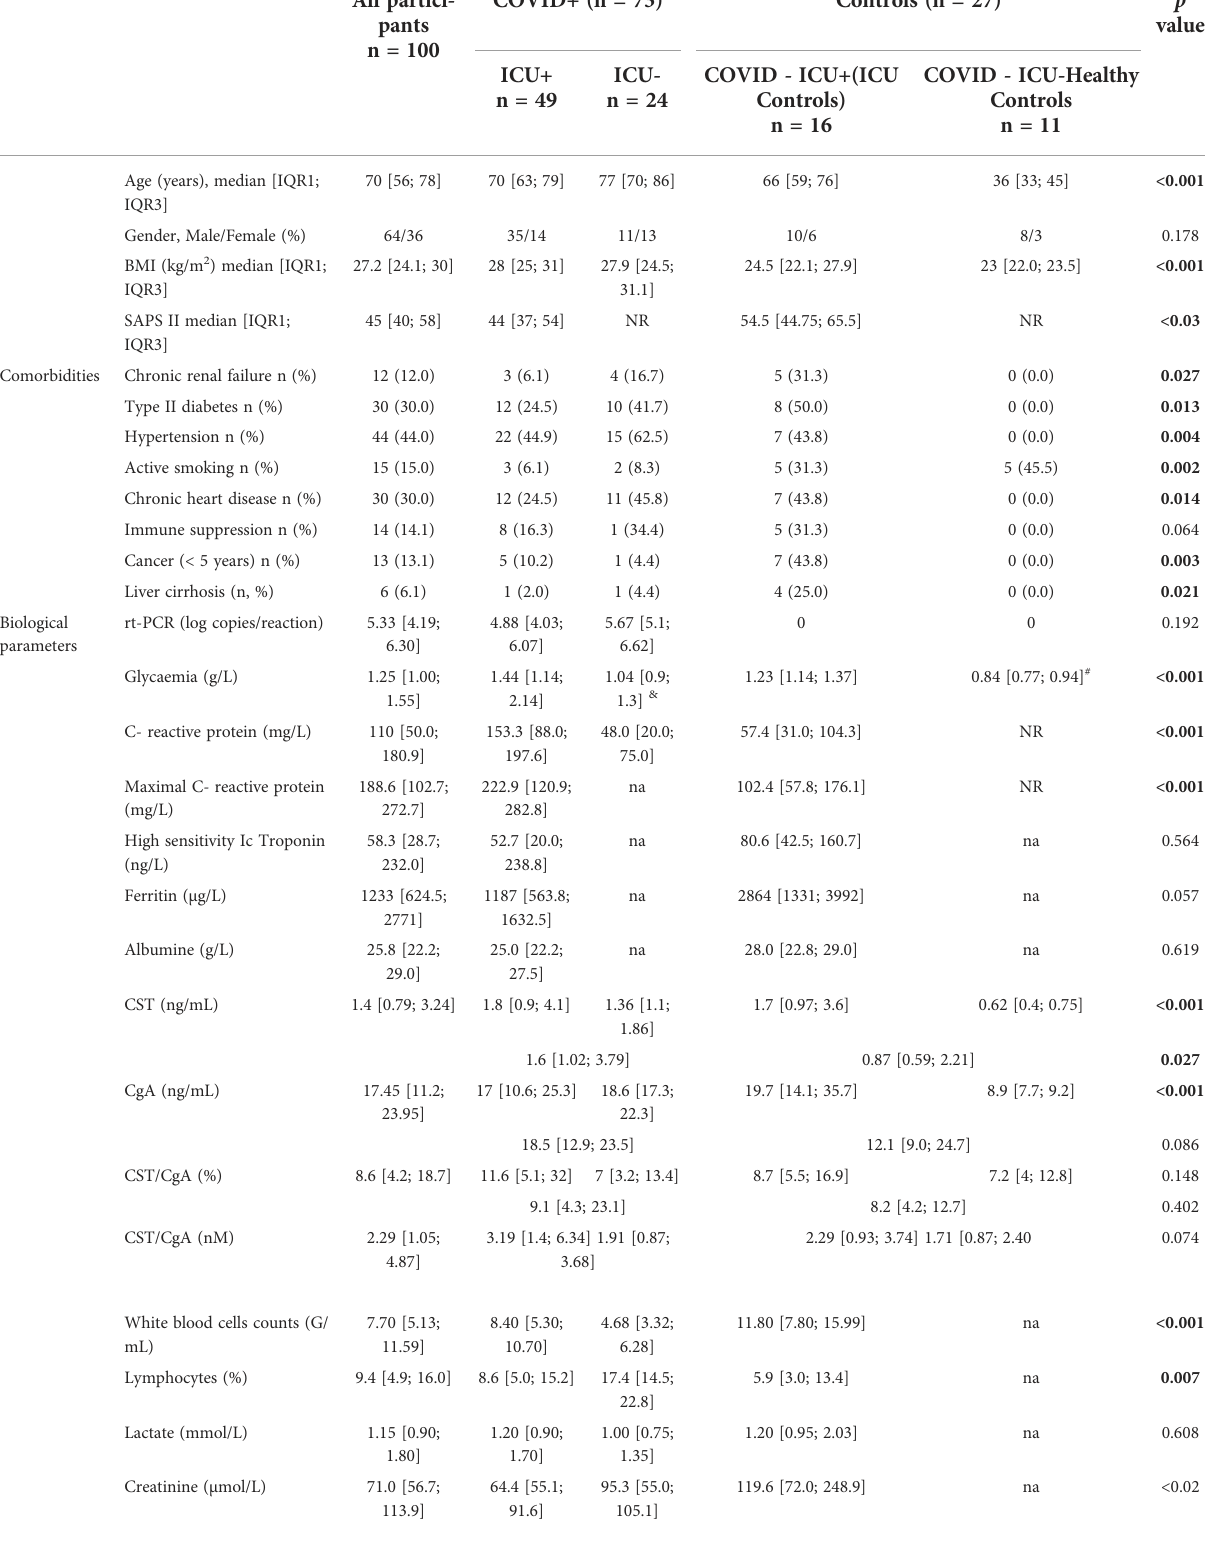
TABLE 1 Characteristics of the study population at inclusion. Bold values correspond to signi fi cative p value. All partici-